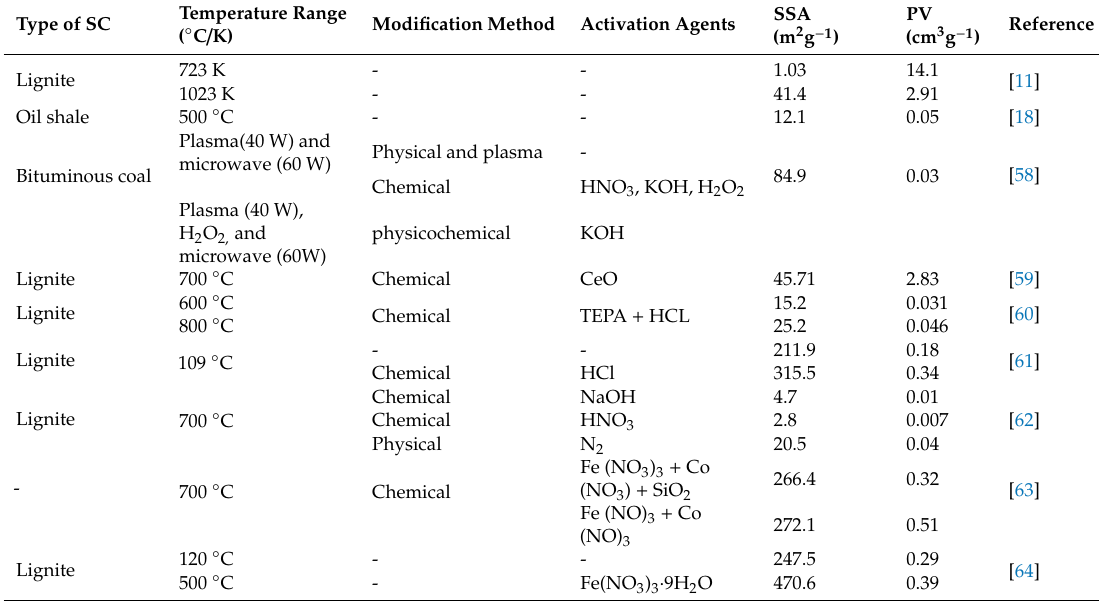
Table 3. Some temperature and activation influenced changes in the SC surface area and pore volume. Type of